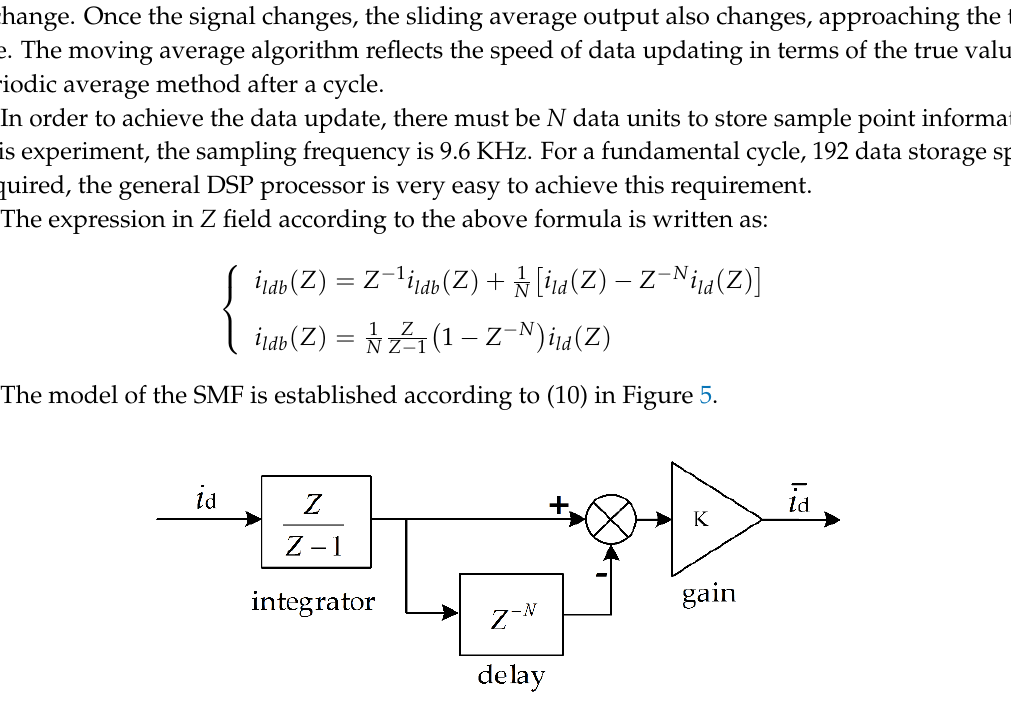
Figure 5. The model of a moving average low-pass filter.